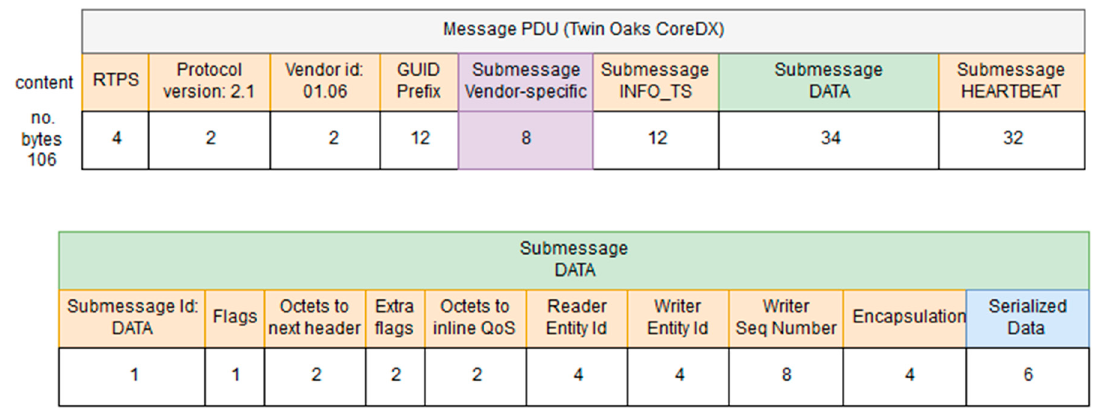
Figure 4. Message PDU with Twin Oaks CoreDX DDS.